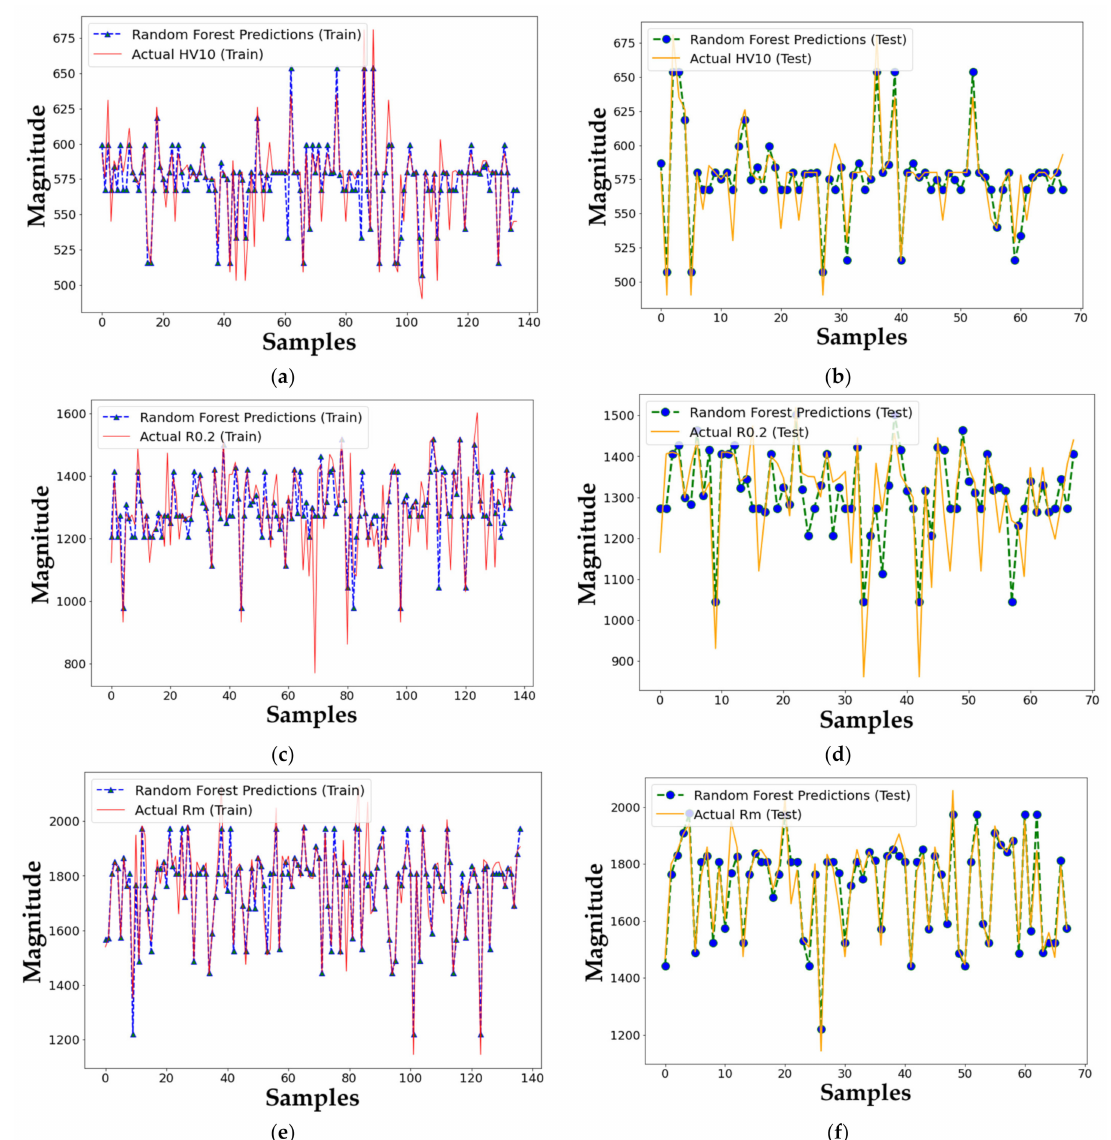
Figure 10. Validation of the Random Forest Regression in modelling the digital twins of the alloy based on HV10 ( a , b ); R0.2 ( c , d ); Rm ( e , f ) in the presence of all inputs including heating, QT, PT, and Pt; ( a , c , e ): Train and ( b , d , f ):